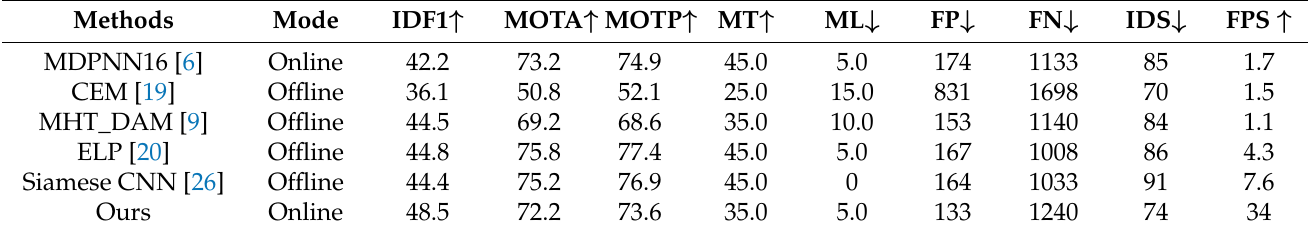
Table 3. Comparison with state of the art on the NCAA Basketball sequences.